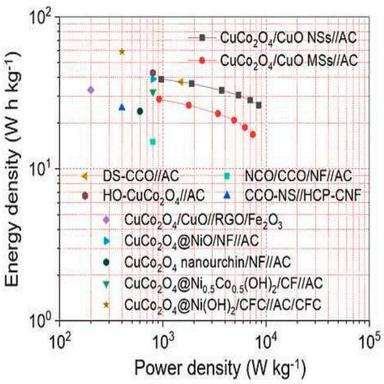
The Ragone plots of CuCo2O4/CuO MSs//AC HSC, CuCo2O4/CuO NSs//AC HSC, and some other CuCo2O4-based HSCs reported earlier.